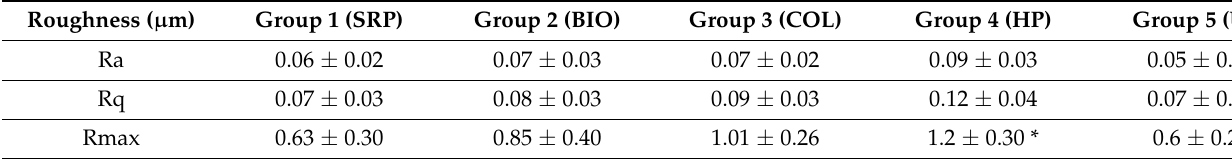
Table 2. Roughness values (Mean ± SD) for each group.